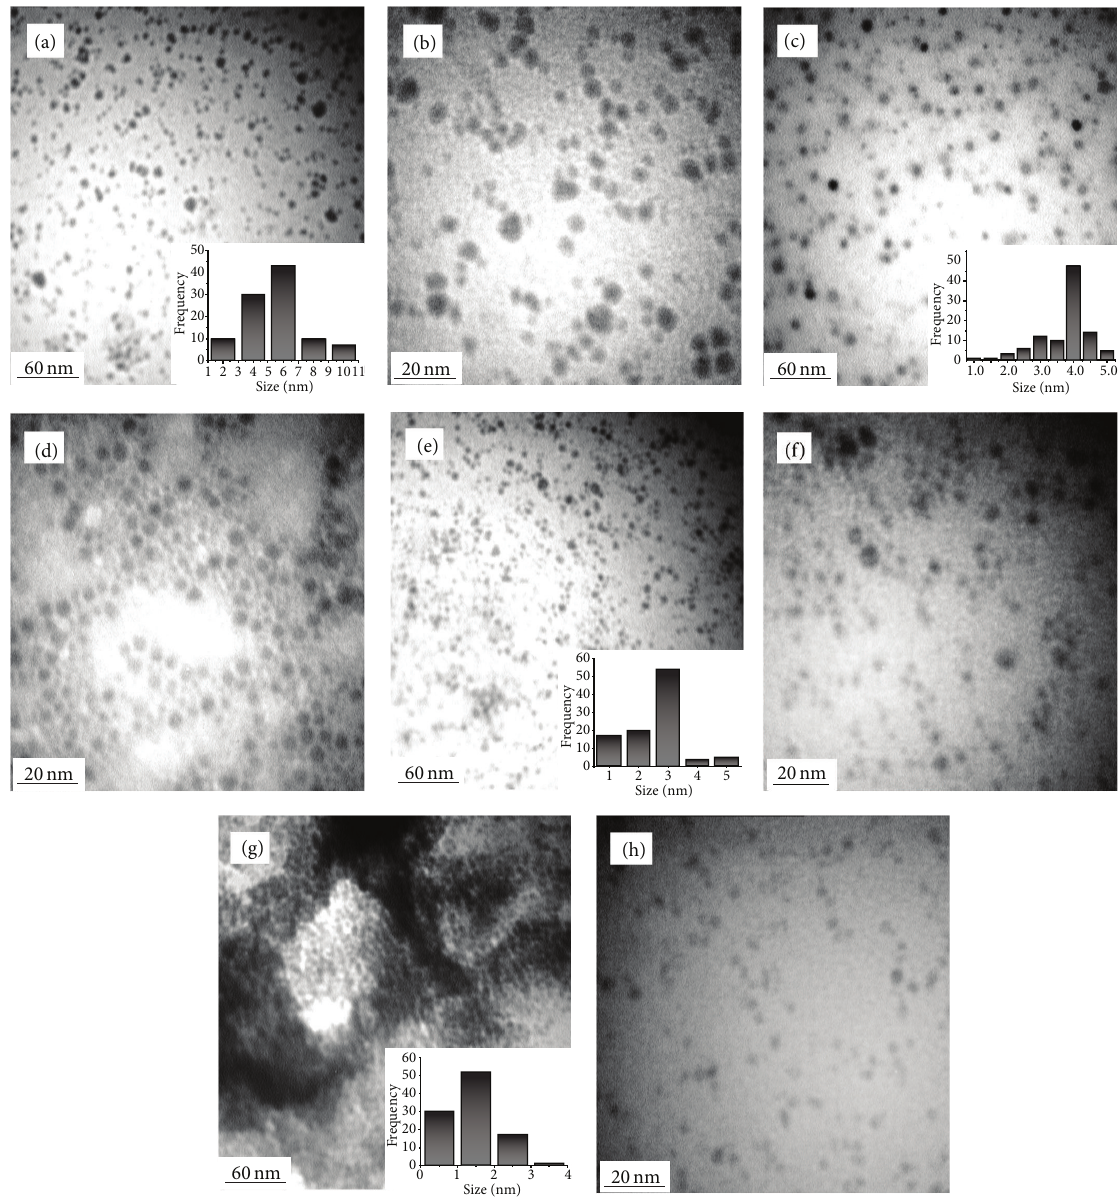
Figure 4: TEM micrographs of as-synthesized nanoparticles and corresponding size distributions: (a) M1, (b) M1 at higher magnification, (c) W3, (d) W3 at higher magnification, (e) M2, (f) M2 at higher magnification, (g) M3, and (h) M3 at higher